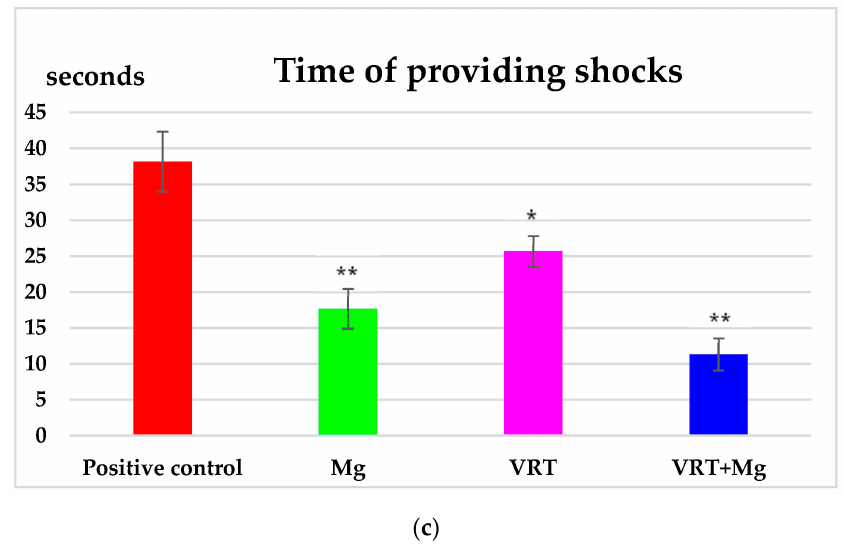
Figure 3. The effects of Mg, VRT and VRT+Mg on time to first shock delivery ( a ) the number of delivered shocks ( b ) and time of providing shocks ( c ) in the treadmill test in rats. Each point represents the mean ± S.D. of the average values for 6 animals per group. The values of the coefficient * p < 0.05, ** p < 0.01 were considered statistically significant versus positive control.